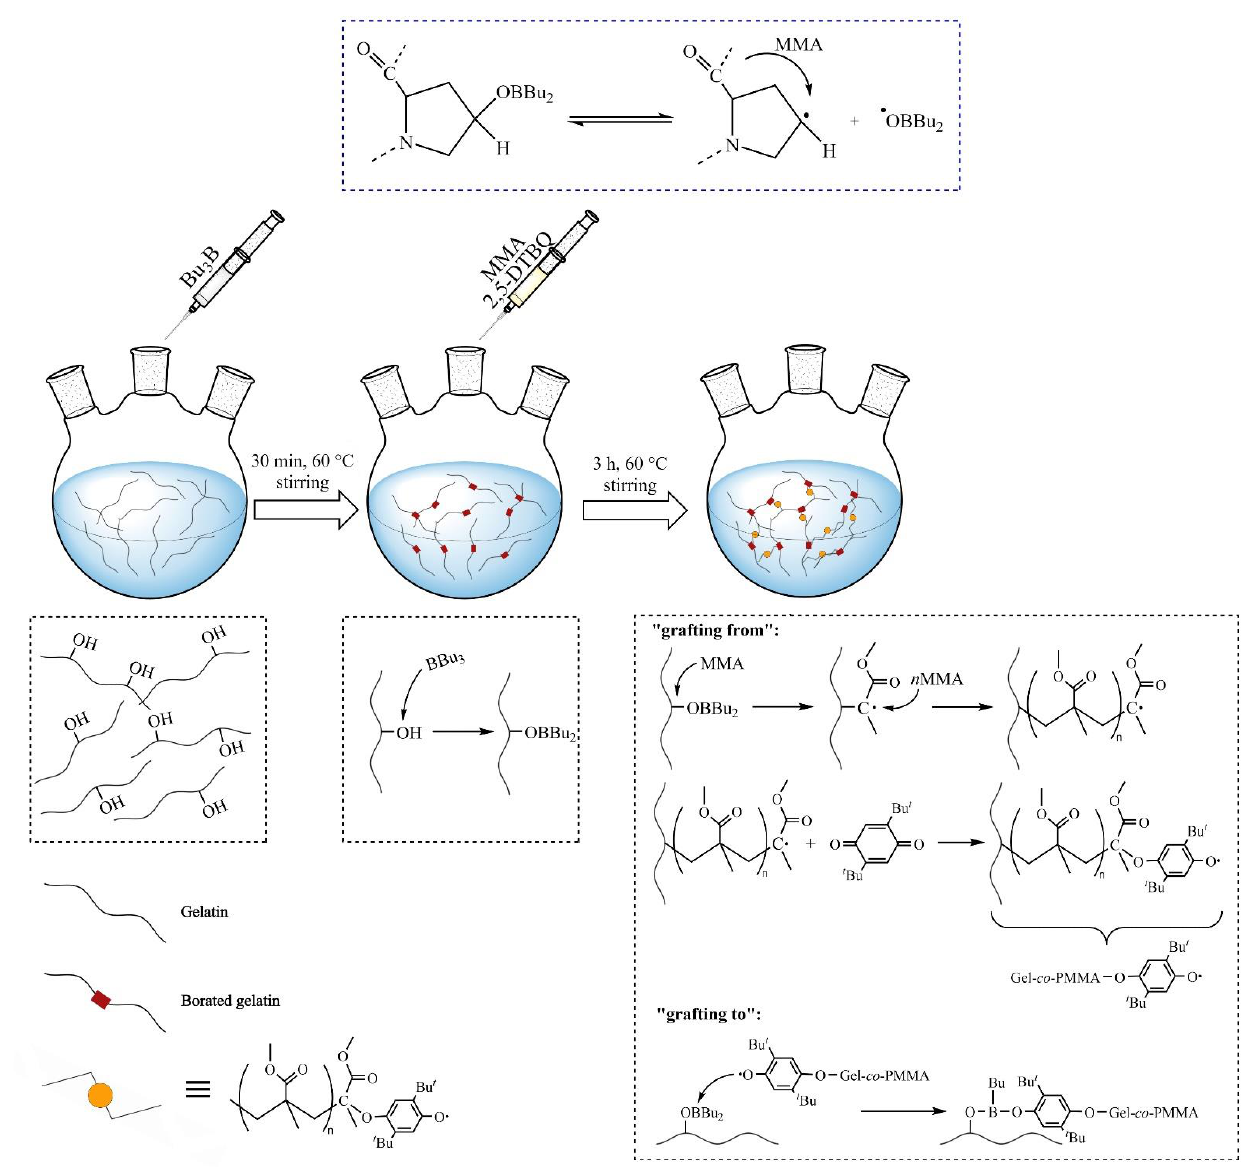
Figure 6. Schematic illustration of the synthesis of graft Gel-PMMA copolymer initiated by TBB and 2,5-DTBQ.